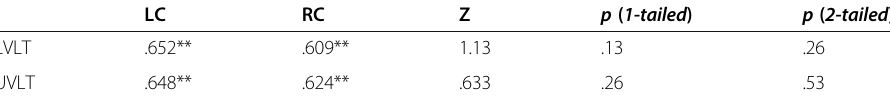
Table 4 Difference between correlations LC RC Z p ( 1-tailed ) p ( 2-tailed ) LVLT .652** .609** 1.13 .13 .26 UVLT .648** .624** .633 .26